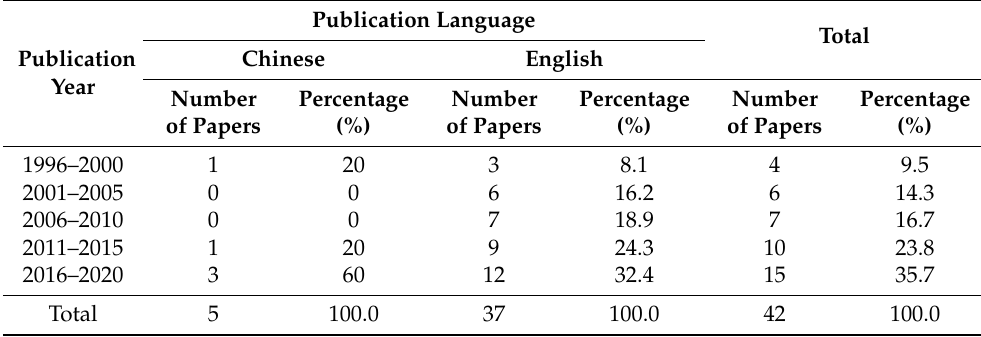
Table 1. Statistics of published journal articles in Chinese and English during consecutive 5 year periods.